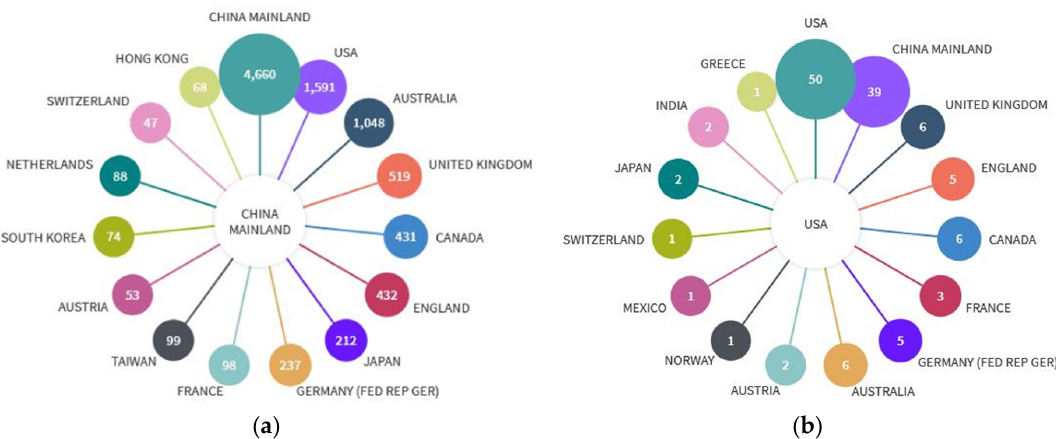
Figure 3. Number of documents as a result of cooperation for China ( a ) and the USA ( b ).